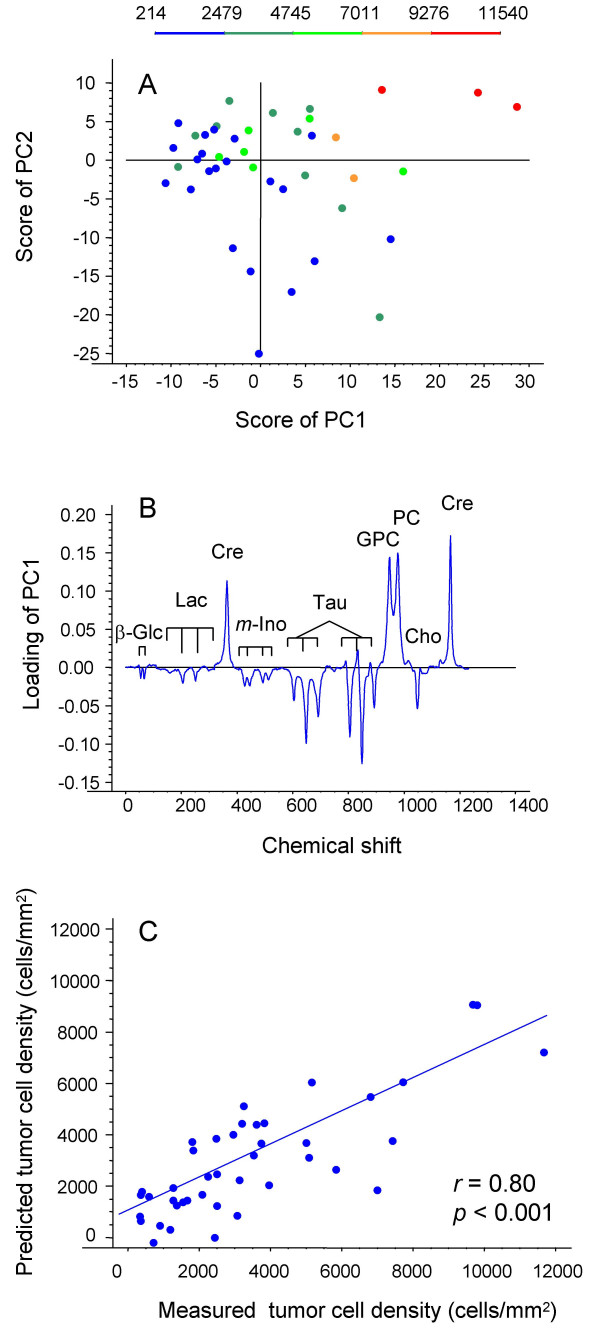
Score plot of first principal component (PC1) versus second principal component (PC2) from partial least square (PLS) regression analysis of tumor cell density to spin-echo spectral data (A), the corresponding loading profile of PC1 (B), and the predicted versus measured tumor cell density (C). In (A) and (C) each point represents the data of a single biopsy. In (A) the color code for tumor cell densities (cells/mm2) is shown. Spectral assignments are abbreviated in (B): β-Glc, β-glucose; Lac, lactate; m-Ino, myo-inositol; Cre, creatine; Tau, taurine; GPC, glycerophosphocholine; PC, phosphocholine; Cho, choline. The Pearson correlation coefficient and p-value are marked in (C). Total residual y-variance and root mean square error of prediction were minimised by retaining 3 PCs in the model. These three PCs accounted for 52% of the total x-variation, and 65% of the total y-variation.